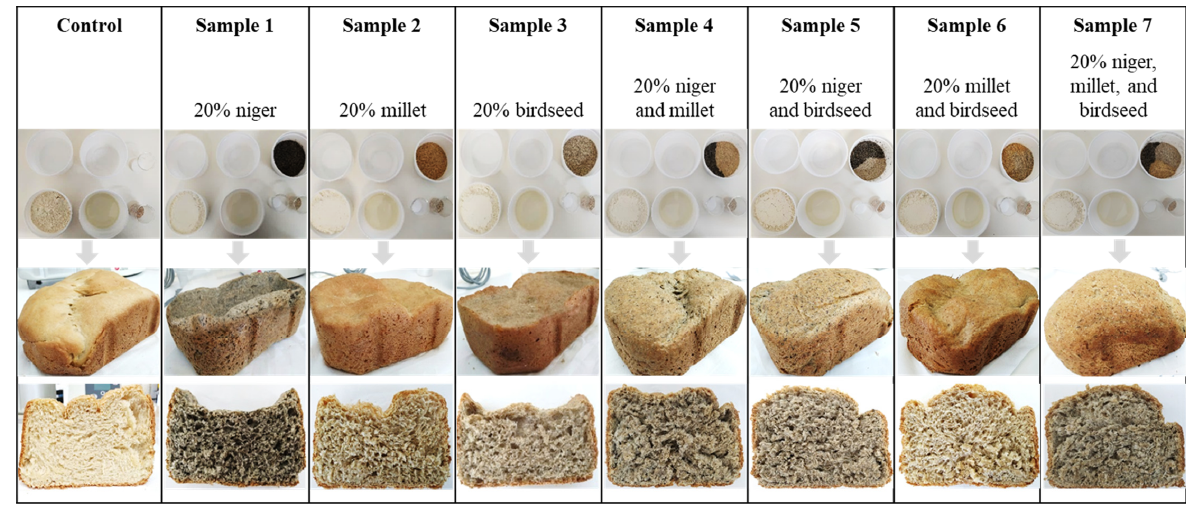
Figure 2. Combinations of the mixtures according to the design of the flours, added quantity of each NCFPs flour and exterior and interior representations of the breads obtained.